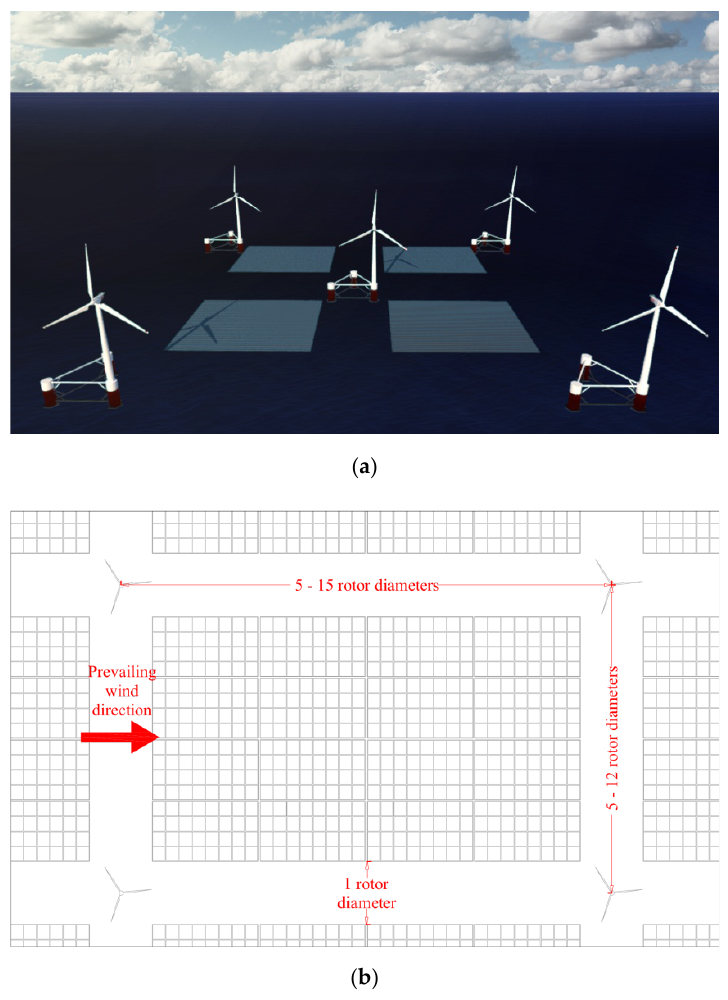
Figure 2. Combined floating wind and solar energy farm: general view ( a ) and schematic layout ( b